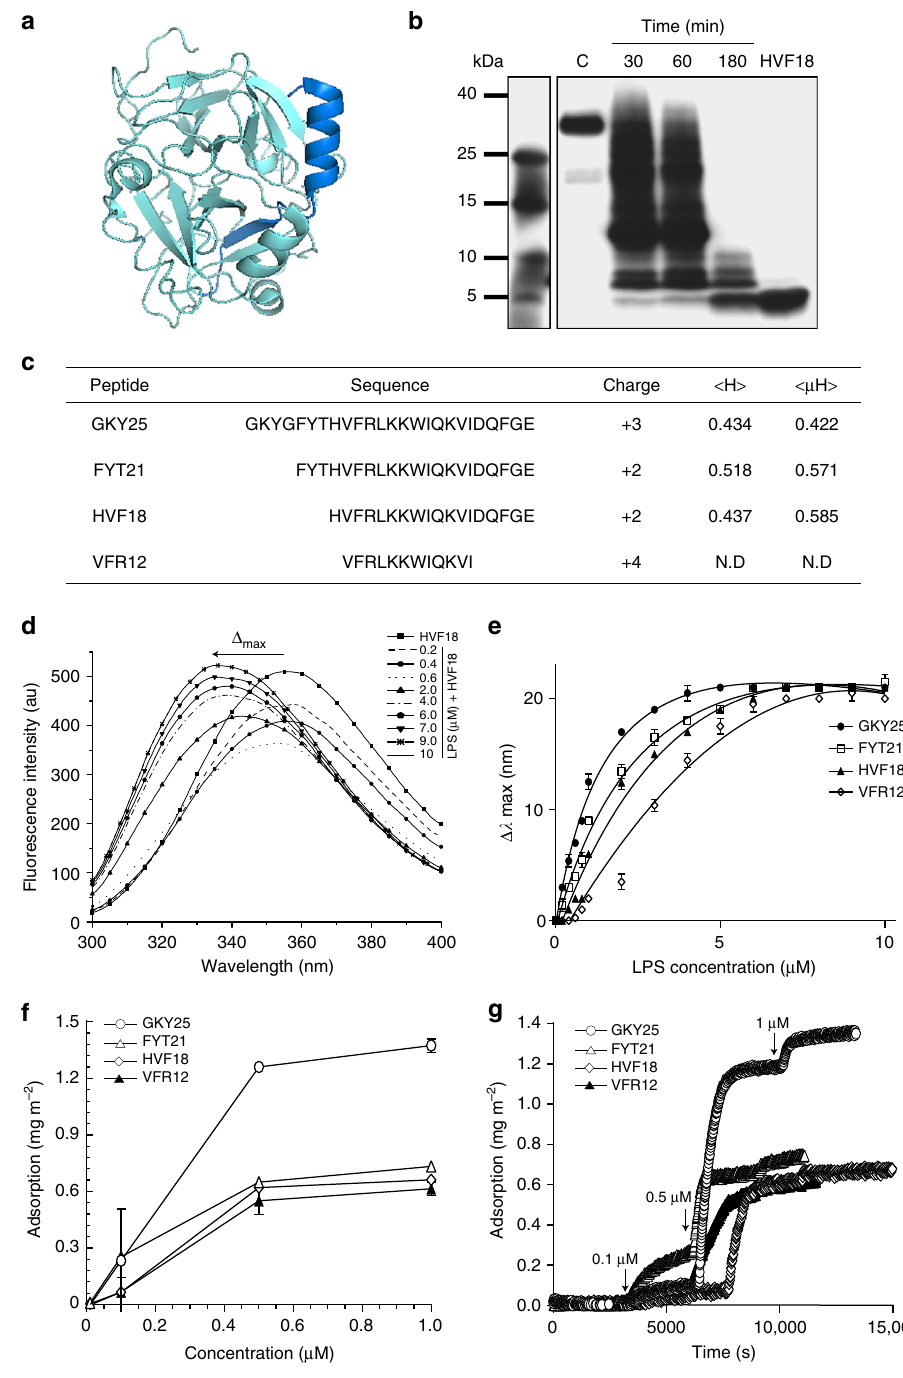
Fig. 1 Thrombin C-terminal peptides, and their binding to E. coli LPS. a 3D model of human α -thrombin (PDB code 1C5L) highlighting thrombin C-terminal peptide fragment. b Western blot analysis of human α -thrombin incubated with neutrophil elastase (NE) for the indicated time period generates thrombin C-terminal peptide fragments of varying lengths. The synthetic peptide HVF18 is loaded as molecular size control corresponding to generated fragments. The marker lane is from the same blot but aligned for clarity. c Table showing thrombin C-terminal peptides amino acid